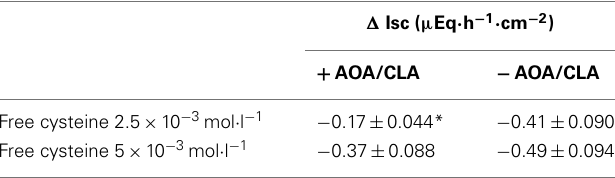
Table 1 | Effect of free cysteine in the presence of inhibitors of H 2 S synthesizing enzymes.